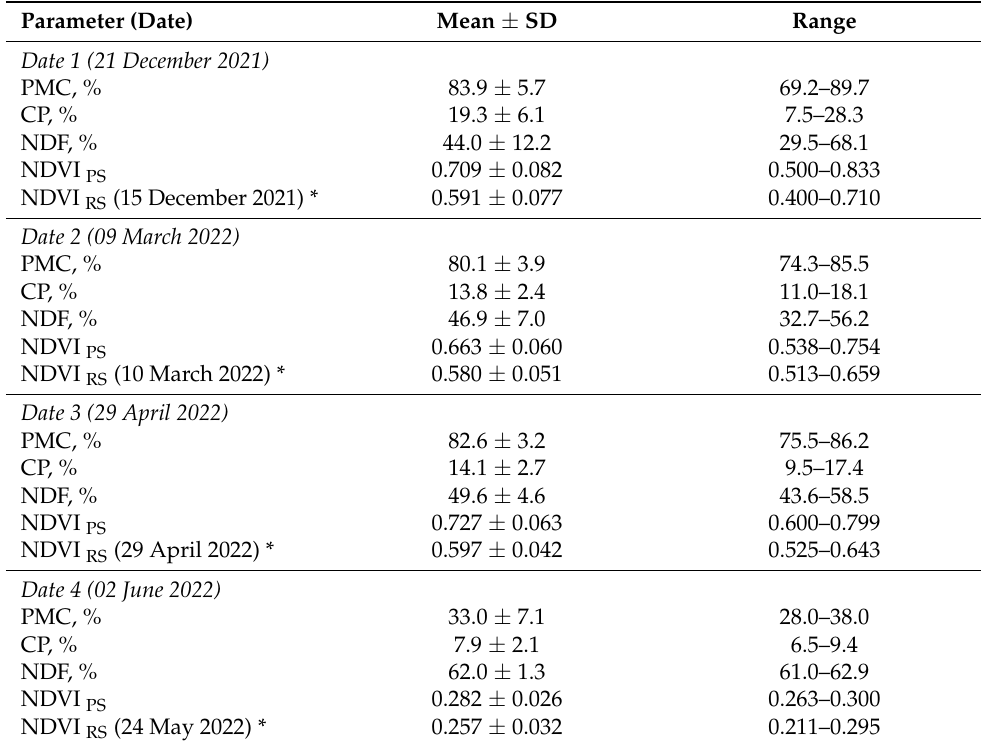
Table 1. Mean ± standard deviation (SD) and range of pasture parameters (pasture moisture content, PMC; crude protein, CP; and neutral detergent fibre, NDF); and normalized difference vegetation index (NDVI) obtained by proximal (PS) and remote sensing (RS) in the vegetative cycle of